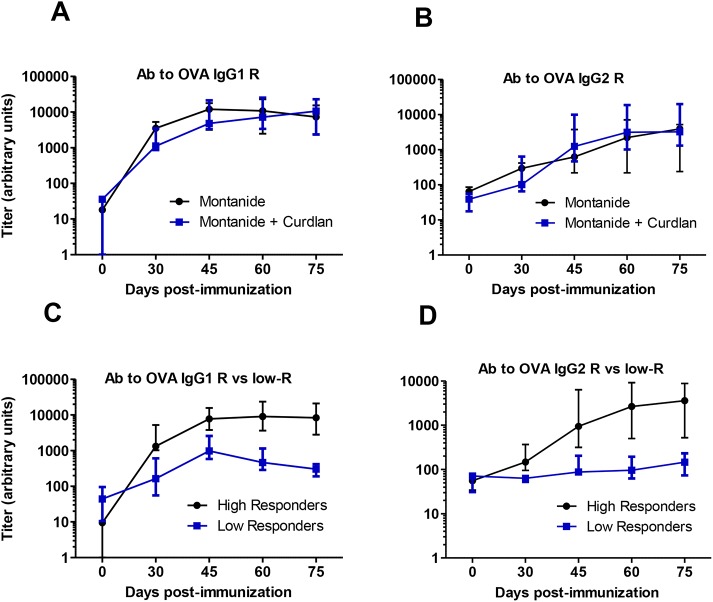
Time-course of the humoral response following immunization with ovalbumin at days 0 and 30.(A & B) Variations of antibody titers (IgG1 and IgG2) in serum samples of the responder cows (R) of the two immunization groups in the IgG1 and IgG2 subclasses. (C & D) Variation of antibody titers (IgG1 and IgG2) in serum samples of responder and low-responder cows (low-R).